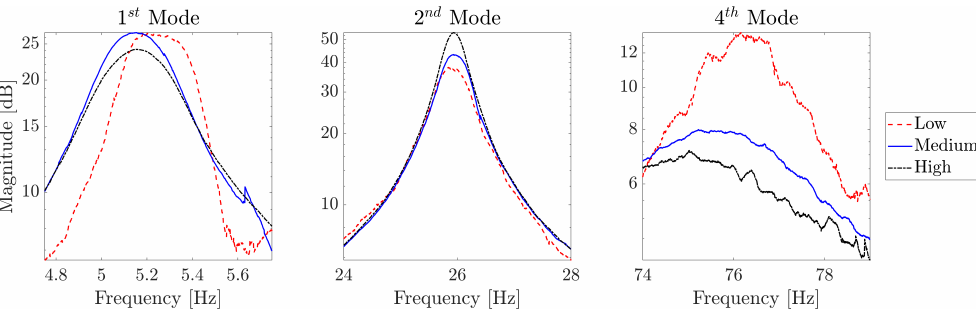
Figure 19. Spar and tube: Comparison of the FRFs of channel #4L for the two input scenarios near